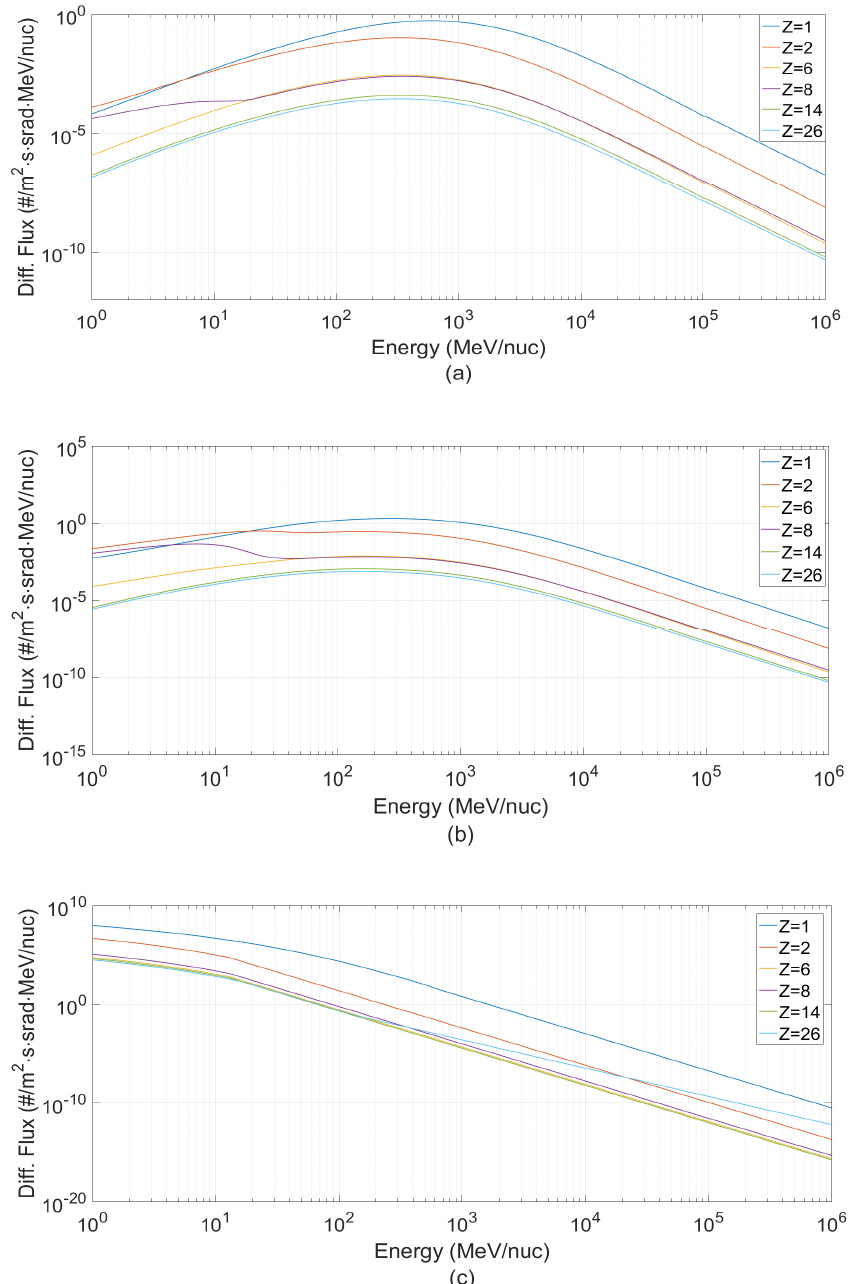
Figure 2. Differential flux of the incoming primary cosmic ray particles as a function of energy for various elements for solar maximum ( a ), solar minimum ( b ), and for solar flare conditions (“Worst Week” scenario) ( c ).